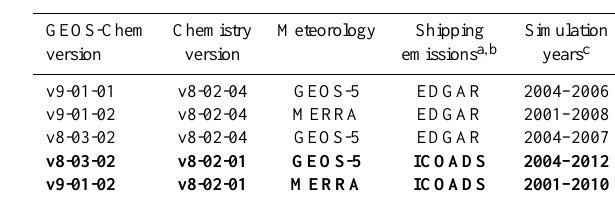
Table 1. GEOS-Chem annual simulations for CMAQ boundaries (recommended in